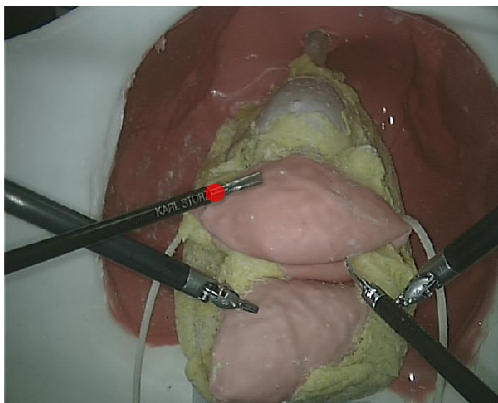
Figure 12. The surgical scenario from the point of view of the DaVinci endoscope; the red circle marks the controlled